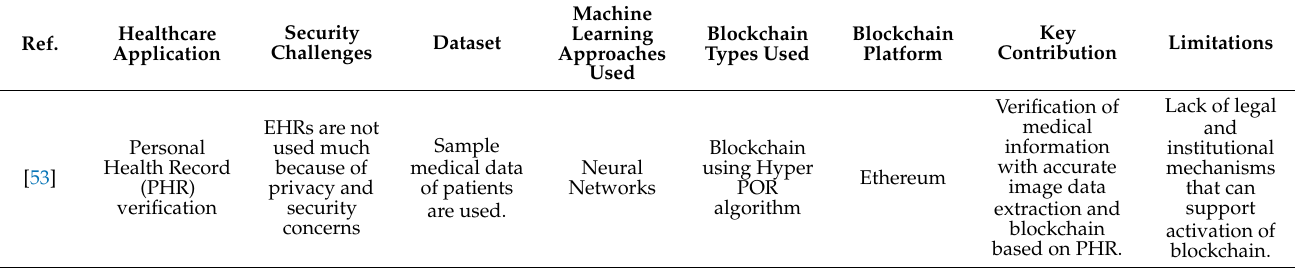
A summary of works on Machine Learning-Enabled Blockchain Technologies for Public